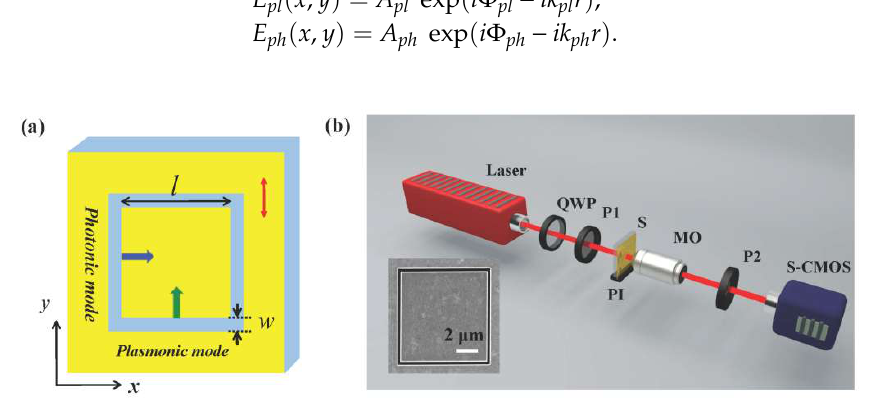
Figure 2. ( a ) schematically shows the square slit. With vertically incident light, photonic mode and plasmonic mode waves are excited by the two vertical slits and two horizontal slits, respectively. ( b ) is the scattered imaging system utilized to experimentally characterize the fabricated square slit (inset).